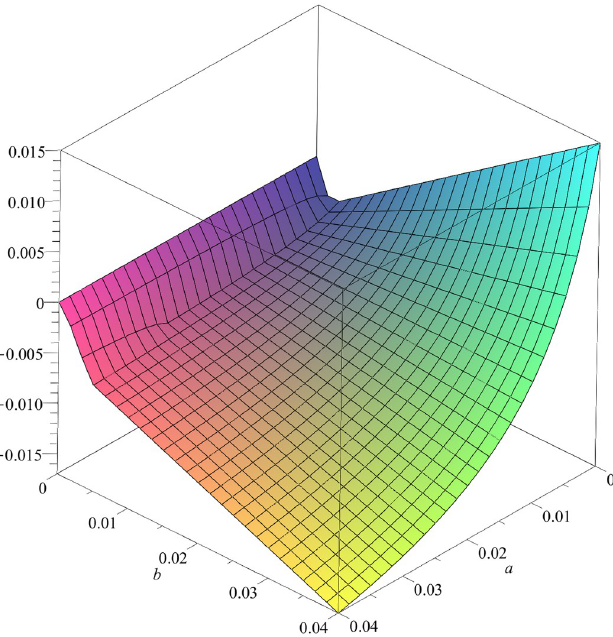
Fig 17. Real part of first eigenvalue of the GM model. The real parts of the first eigenvalue of the Jacobian matrix in dependence of the parameters a (sigmaa) and b (mua).